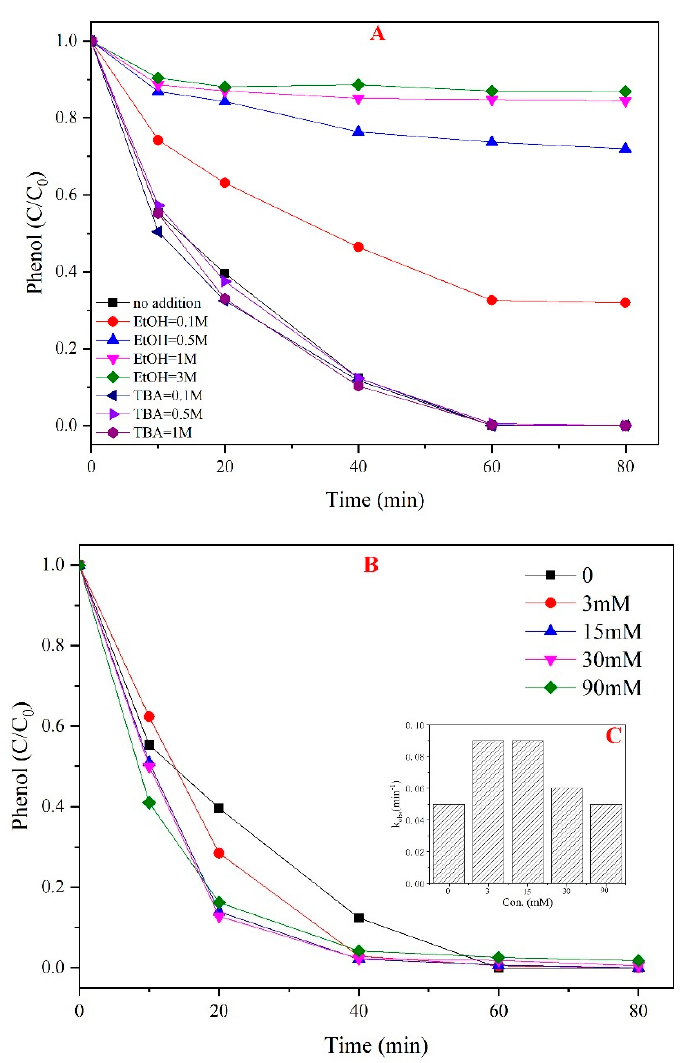
Figure 3. Effect of scavengers and chloride ions. ( A ) Effect of EtOH and TBA, ( B ) different concentration of Cl − , ( C ) k obs of PMS/CoMgAl-LDH system.